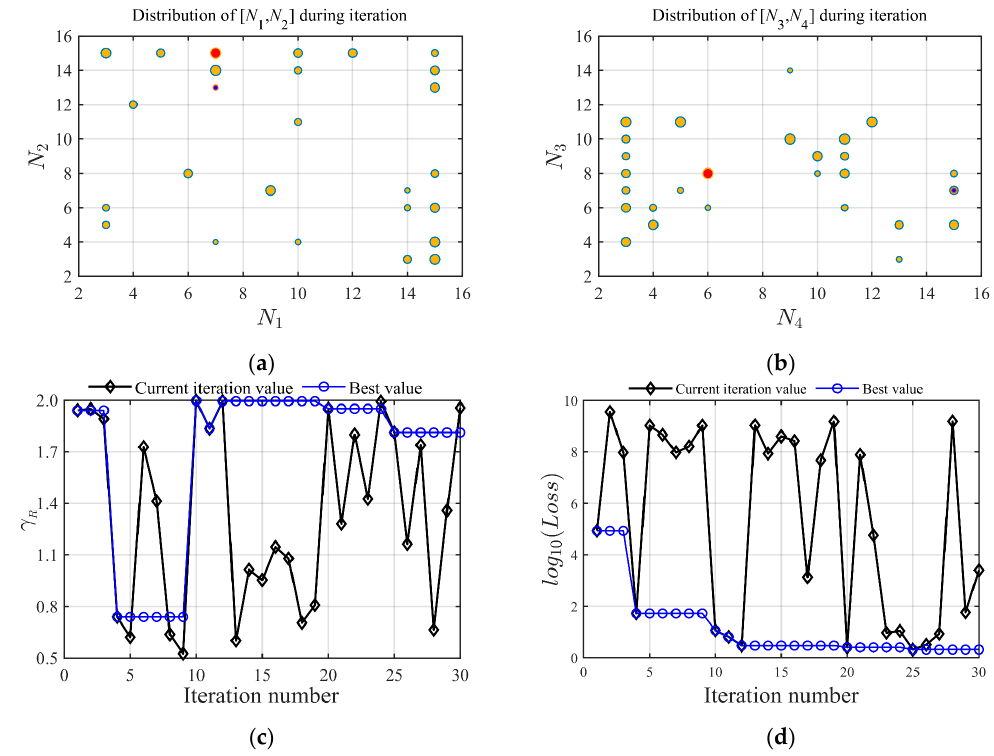
Figure 5. The solution results of the hyper-parameters based on Bayesian optimization: ( a ) iterative scatter distribution of N 1 , N 2 ; ( b ) iterative scatter distribution of N 3 , N 4 ; ( c ) iteration trajectory of the trust coefficient γ R ; ( d ) the change curve of loss